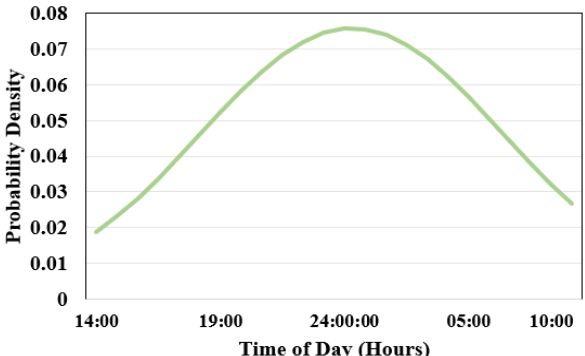
Fig.4. Gaussian Distribution of initial plug-in time of PHEVs